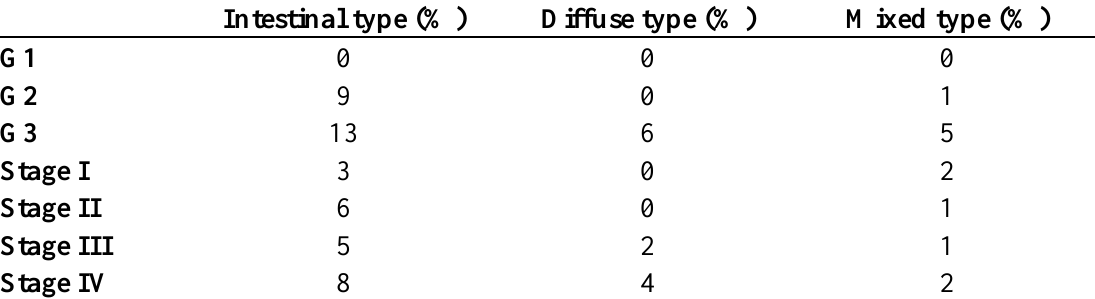
Table 2. Grading and staging